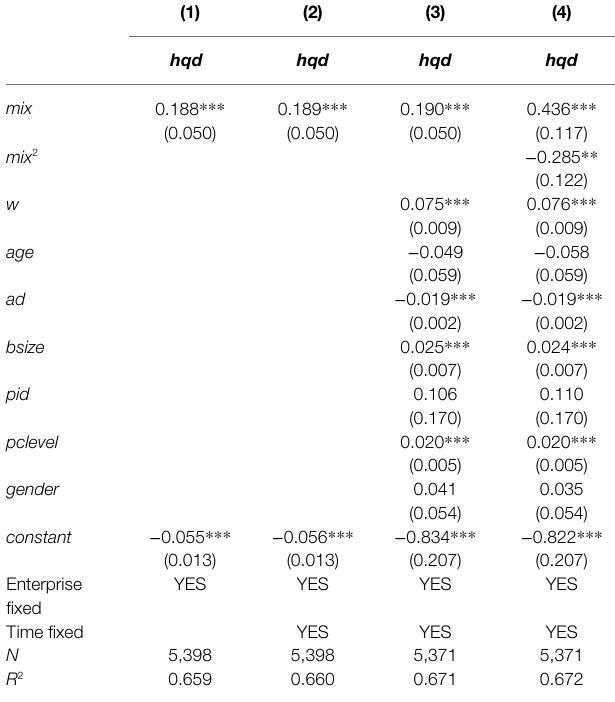
TABLE 4 | Baseline regression